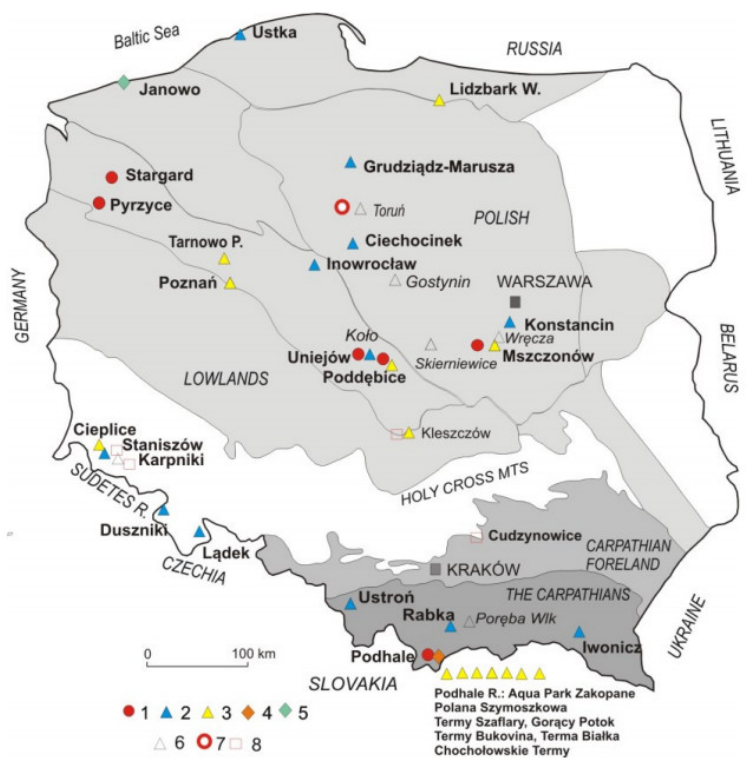
Figure 1. Geothermal uses in Poland in 2018: 1. District heating plants; 2. Health resorts; 3. Recrea- tion centers; 4. Wood drying; 5. Fish farming; 6. Some recreation centers in realization; 7. Heating system in realization; 8. Individual heating systems (individual heating systems in some recreation centers are not marked) [87].